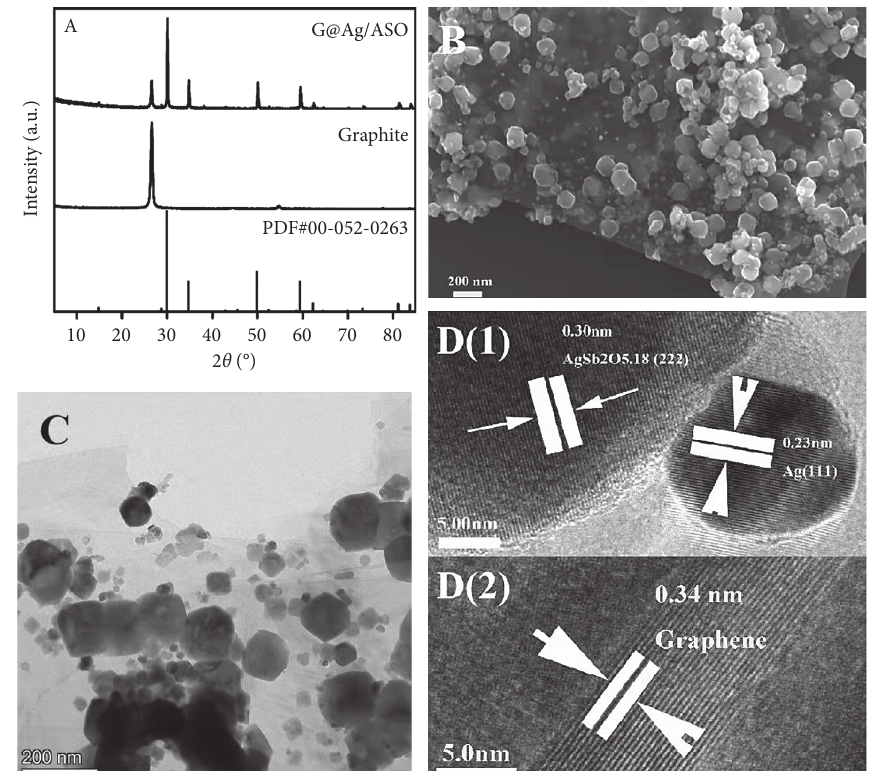
Figure 2: (a) X-ray diffraction (XRD) pattern, (b) SEM, (c) TEM, and (d) HRTEM images of G@Ag/ASO composite.